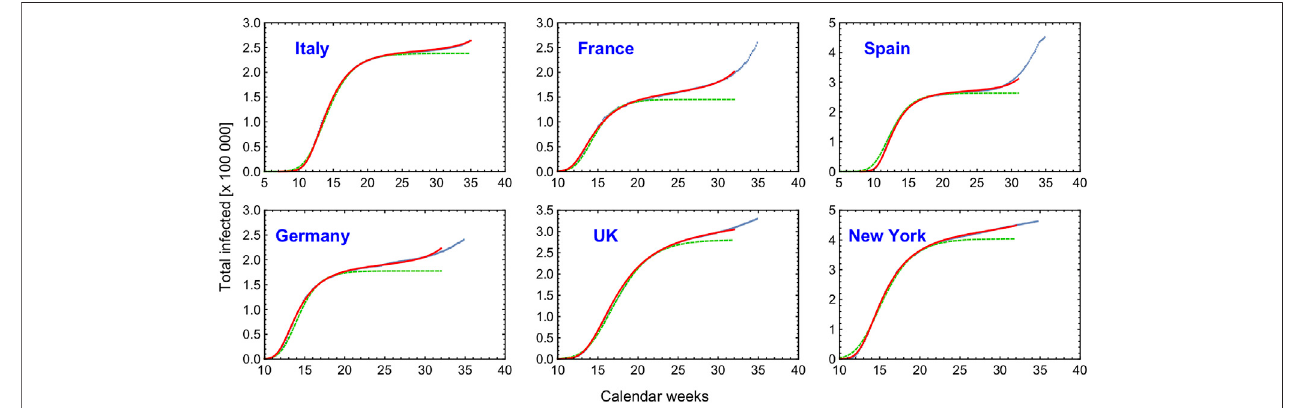
FIGURE 5 | Fit of the CeRG solutions (red curves) compared to the total number of infected cases (blue dots) adjourned to the 28th of August. For comparison, in dashed green we show the eRG fi rst wave fi ts obtained in [26], which do not feature the strolling dynamics. The epidemiological data is from www.worldometer.info.